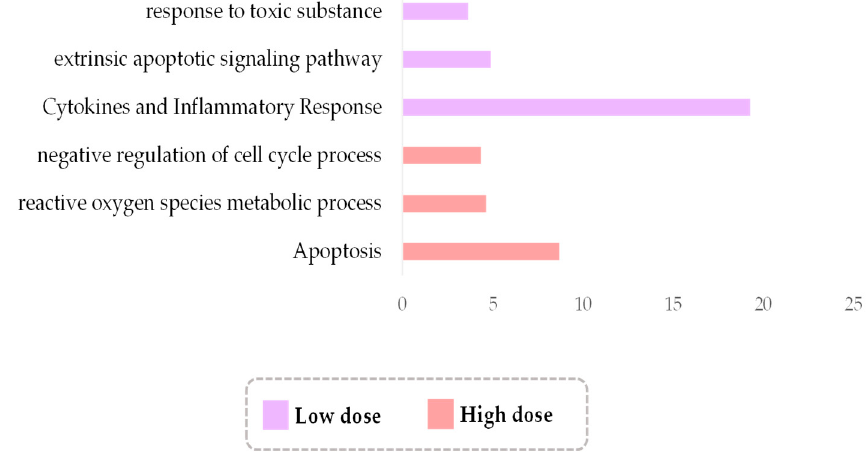
Figure 5. Overrepresented biological pathways (affinity propagation) for all 445 DEGs in low-dose (0.3–0.5 Gy) radiation group and all 668 DEGs in high-dose (0.6–2.0 Gy) radiation group considering all types of irradiation. The x -axis corresponds to the enrichment ratio.